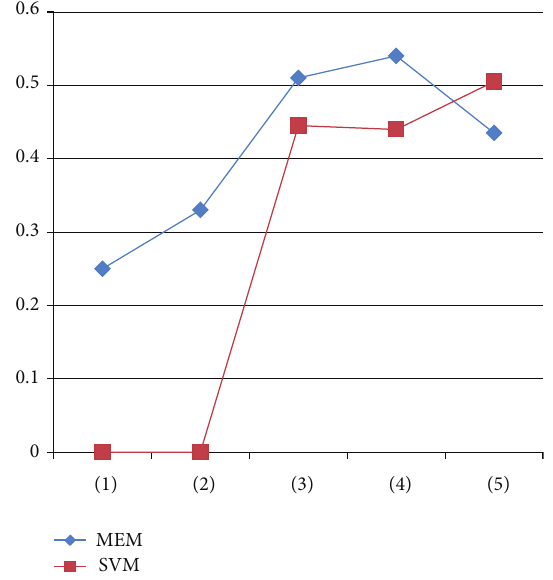
Figure 3: Correct pleasant/unpleasant classification ratios with different